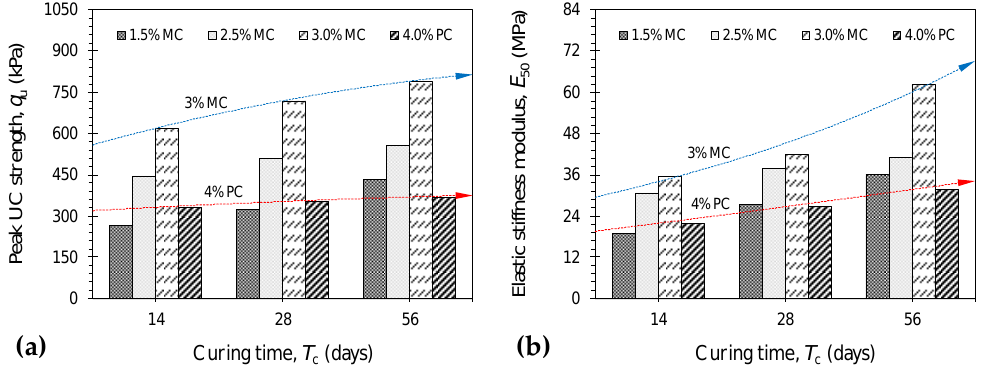
Figure 4. Variations of ( a ) peak UC strength q u and ( b ) elastic stiffness modulus E 50 against curing time for the samples treated with 1.5%, 2.5% and 3% MC and 4% PC.